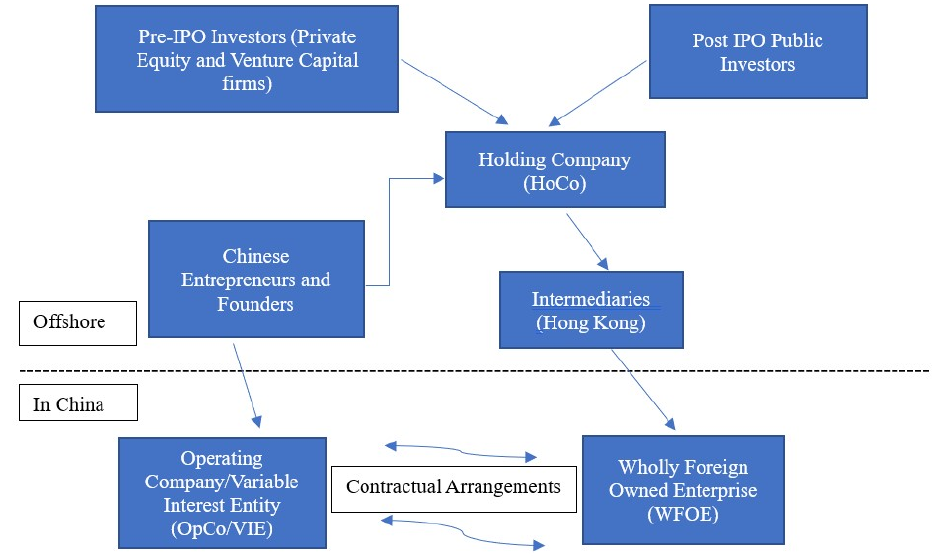
Figure 2. Conceptual Organizational Chart of the VIE Structure. Sources: The Author’s Composition Based on (Gills 2011) and (Securities and Exchange Commission 2014).